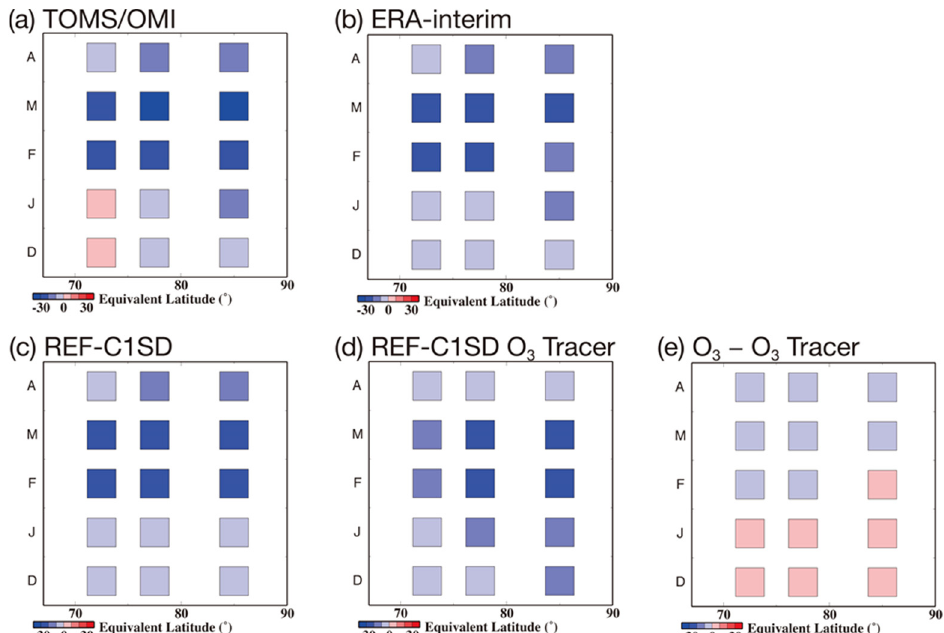
Figure 7. ( a ) Equivalent latitude–month section of the total ozone anomaly for QBO-W/S min years from TOMS/OMI data. The horizontal axis indicates equivalent latitude, and the vertical axis denotes the month from December (bottom) to April (top) (“D” denotes December, “J” January, and so on) The interval for the color scale is 10 DU. ( b ) Same as ( a ), but for ERA-Interim data. ( c ) Same as ( a ) but for the REF-C1SD experiment. ( d ) Same as ( c ) but for the total ozone anomaly of the passive ozone tracer. ( e ) Subtraction of the passive ozone tracer anomaly ( d ) from the ozone anomaly ( c ).